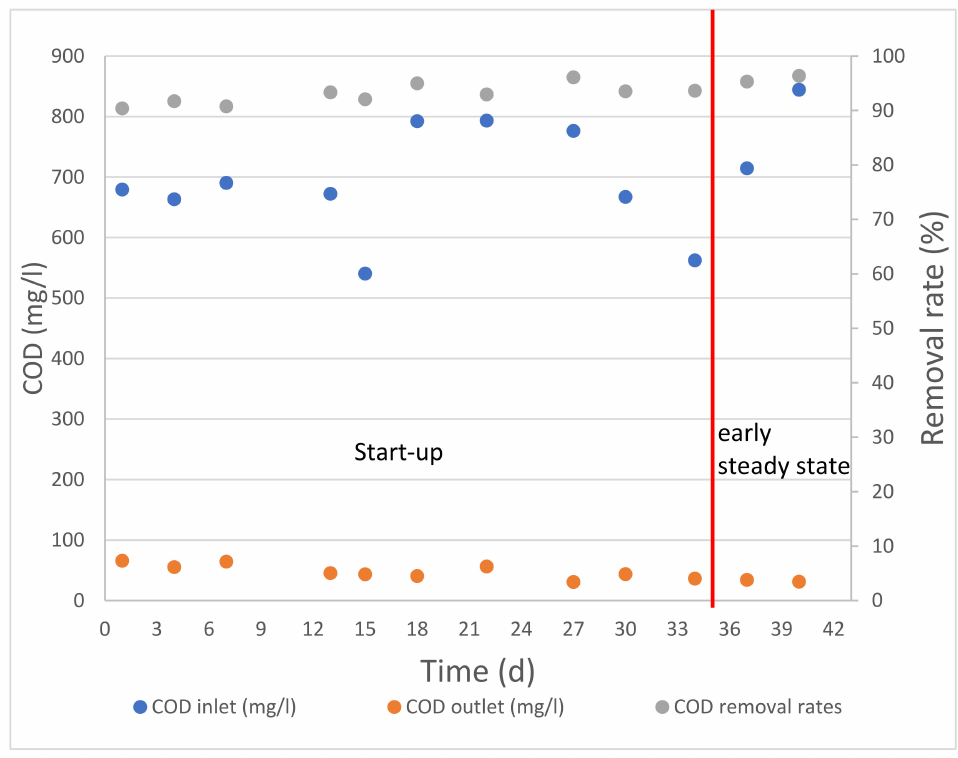
Figure 9. Start-up